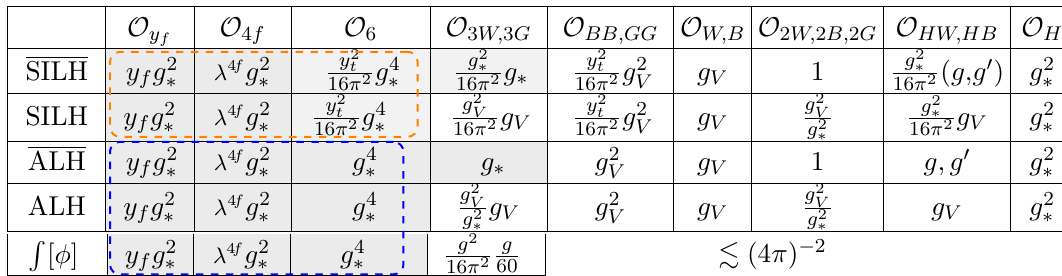
Table 1 . Scaling of the coe(cid:14)cients of the various D = 6 operators in terms of couplings, in the framework of the SILH ((cid:12)rst line), the ordinary SILH (second line), the ALH (third line), the ALH (fourth line), and when integrating out a narrow scalar S (1 ; 2) structure, see text for details.